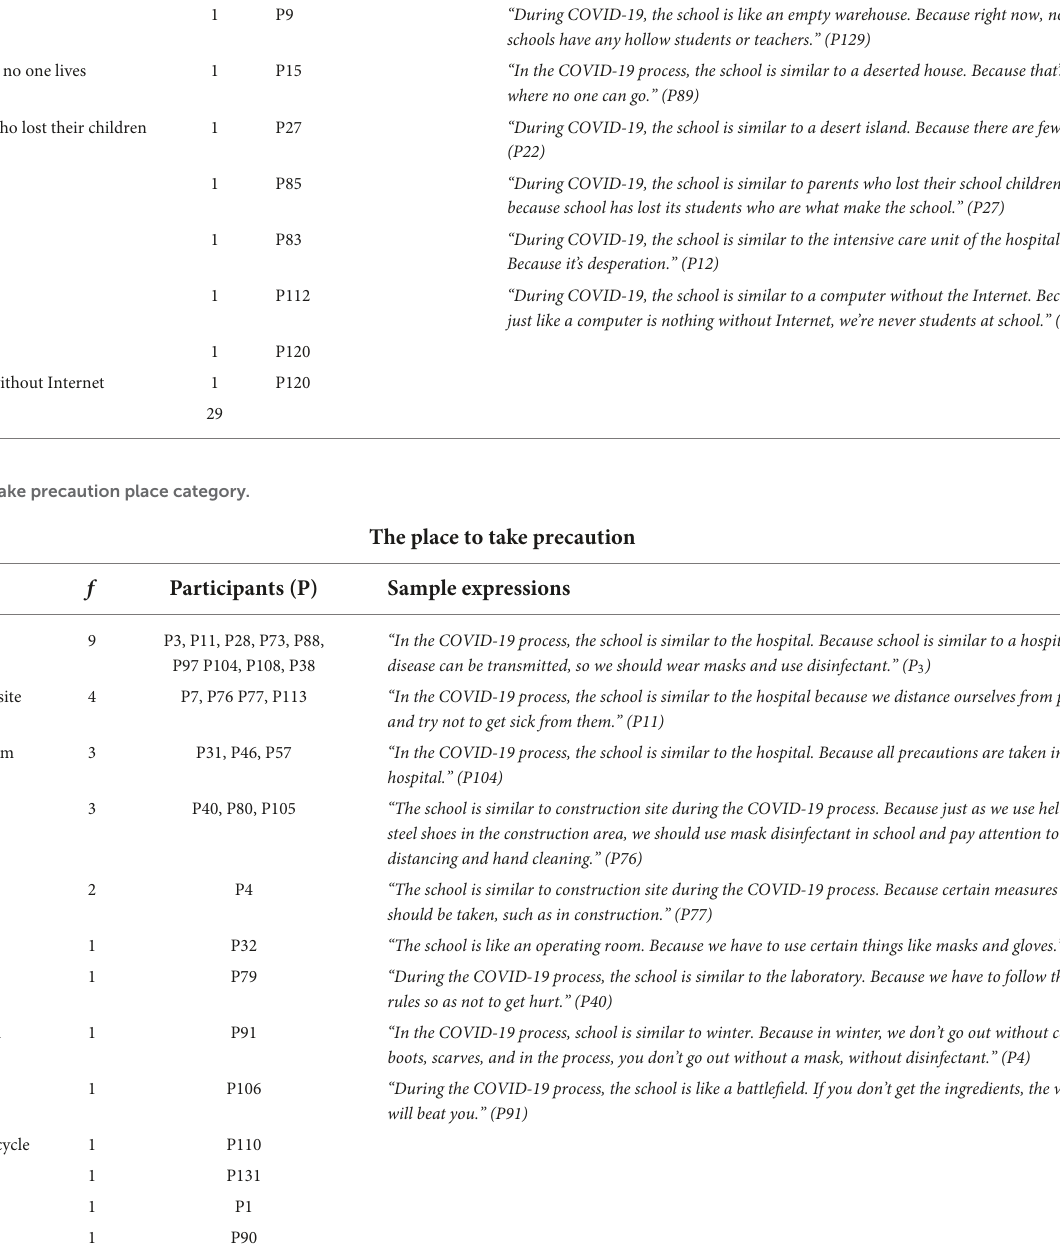
TABLE 13 Lack of complementary element category.